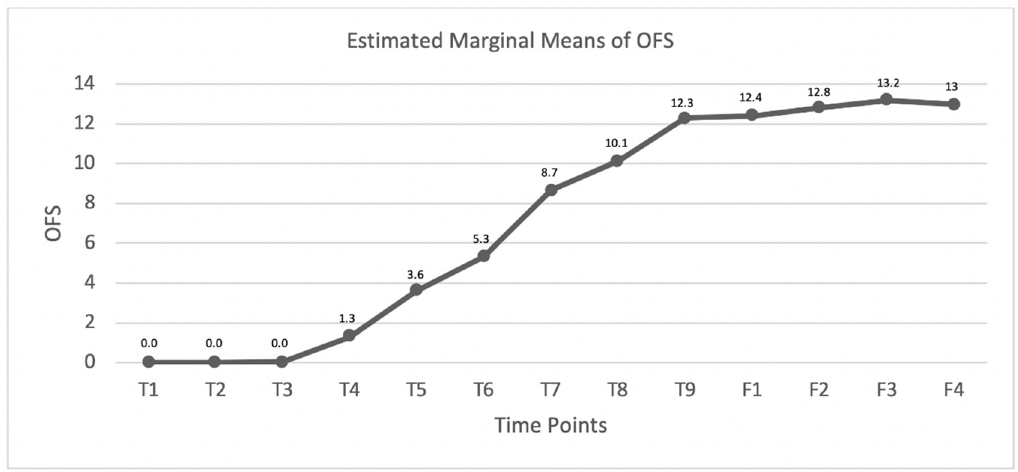
Figure 10. Graphic describing the OFS mean evolution within the DPP − dogs that recovered DPP in the study group (SG).